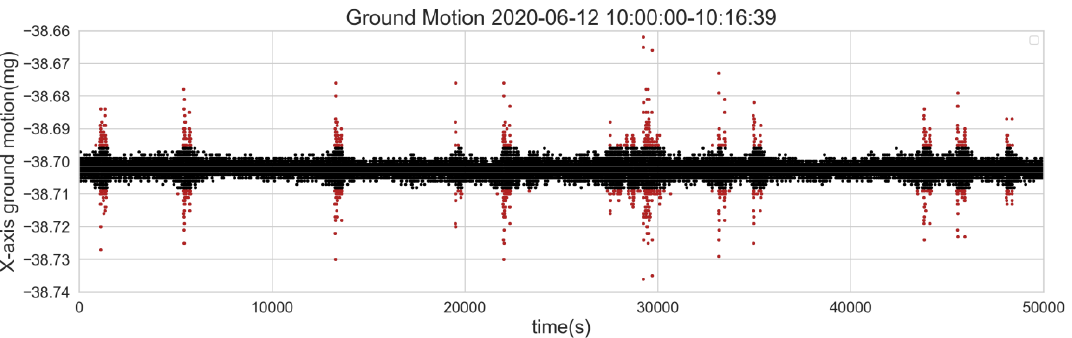
Figure 5. Display of data noise level based on the 3δ criterion (signal before noise removal) .